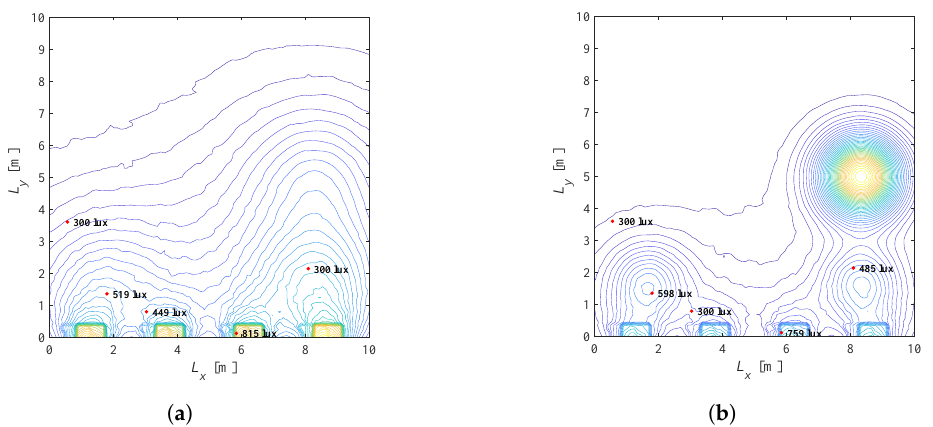
Figure 18. Solution of the Problem 4 defined in (22) for different semi-angles, λ = 0.01. ( a ) Φ 1/2 = 60 0 , a = 0.1, G = 0.22. ( b ) Φ 1/2 = 20 0 , a = 0.1, G =